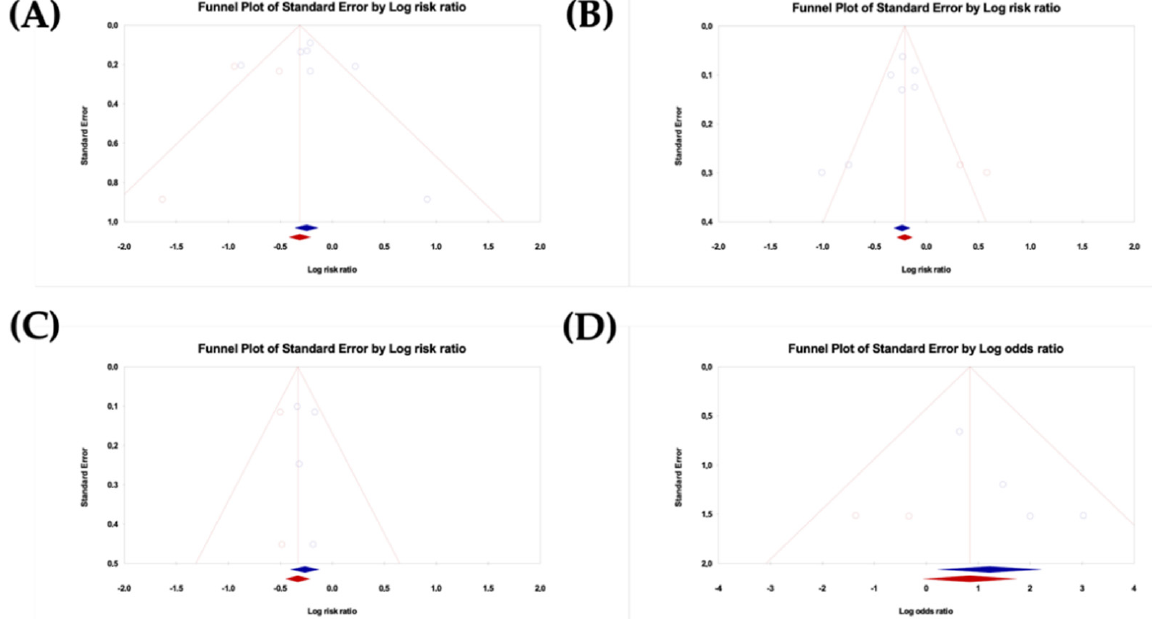
Figure 9. Funnel plots for the outcomes of this meta-analysis adjusted by Trim and Fill approach. ( A ) Histological improvement to normal or CIN 1, ( B ) Vaccine efficacy for complete resolution, ( C ) DNA clearance, ( D ) HPV-T cell responses after